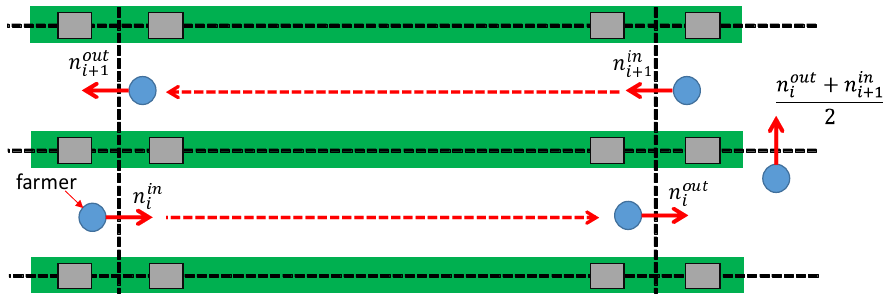
Figure 4. Passage restriction. A farm laborer can move from one passage to the next only by walking